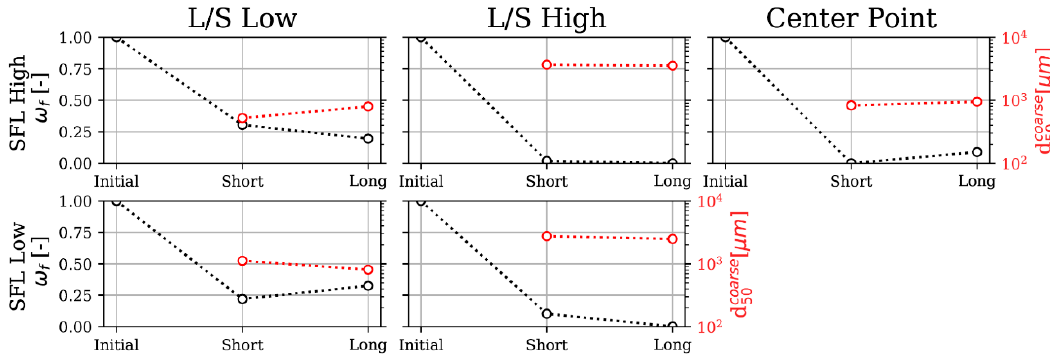
Figure 4. Fraction of fines and d 50 of coarse particles calculated by a bimodal Gaussian fit over screw length for all combinations of low and high SFL and L/S parameters and a center point.